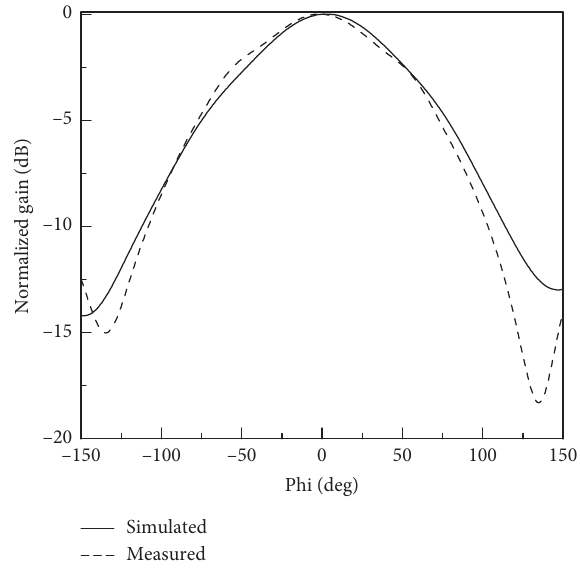
Figure 14: E-plane radiation characteristics of the proposed nose- cone conformal slot array.